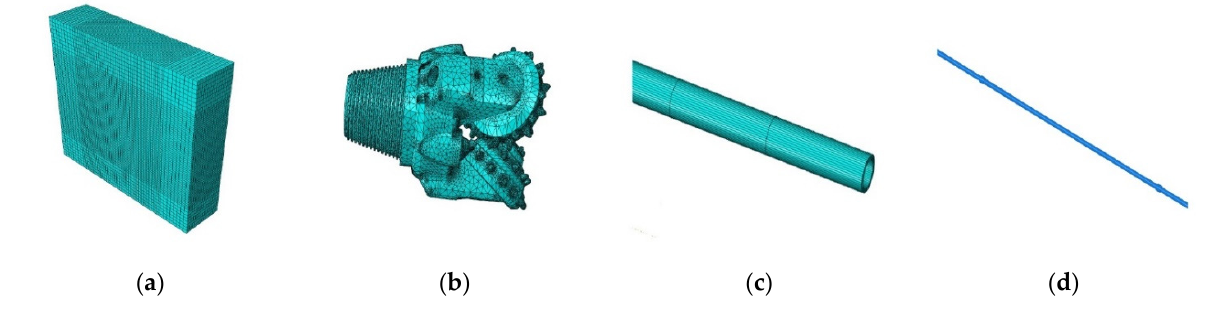
Figure 4. Meshing. ( a ) Rock. ( b ) Drill bit. ( c ) Borehole. ( d ) DS.